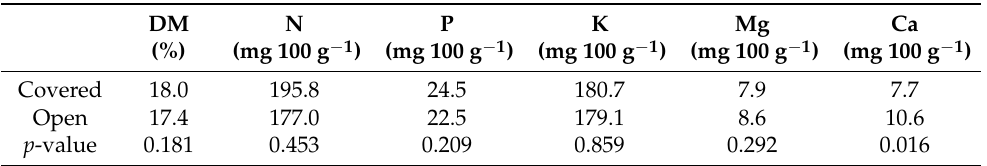
Table 6. Mean values of the dry matter content (DM) and mineral composition of ‘Santina’ sweet cherries grown outside (open) and inside high tunnels (covered) in the Central Valley of Chile. Plot 2, season 2019/2020.